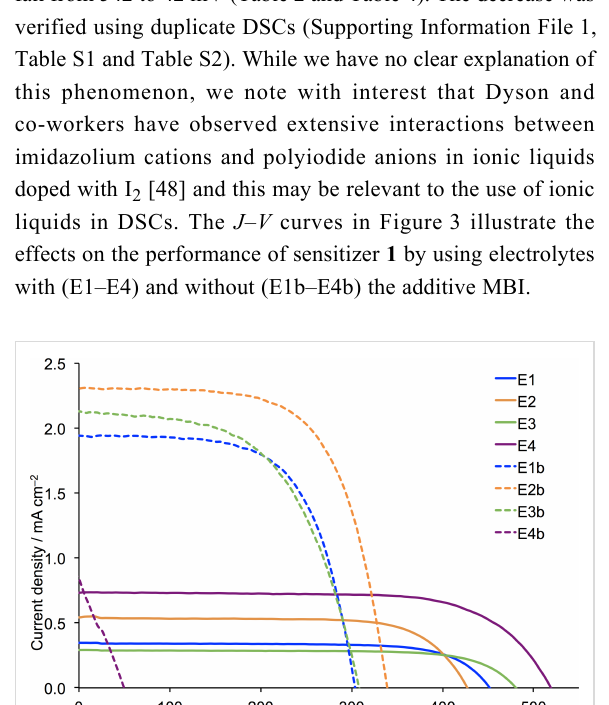
Figure 3: J–V curves to illustrate the effects of removing the MBI addi- tive from electrolytes E1–E4.